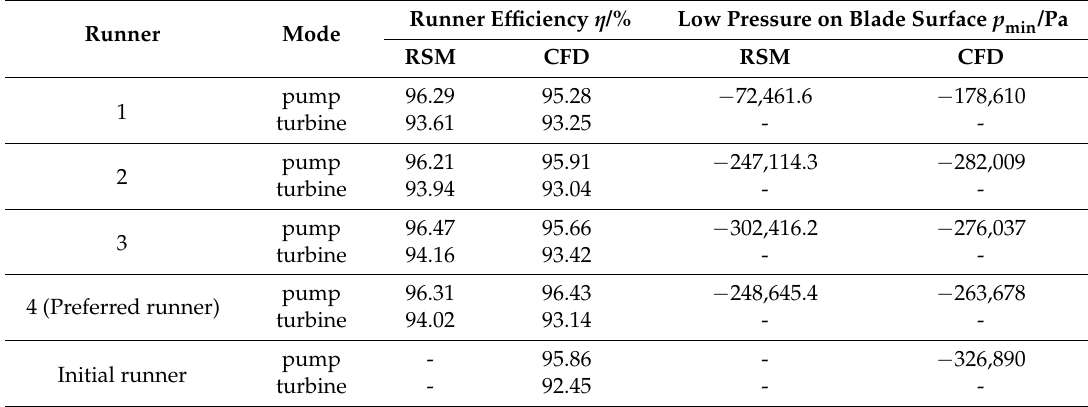
Table 5. Comparison of the selected runners and the initial runner.